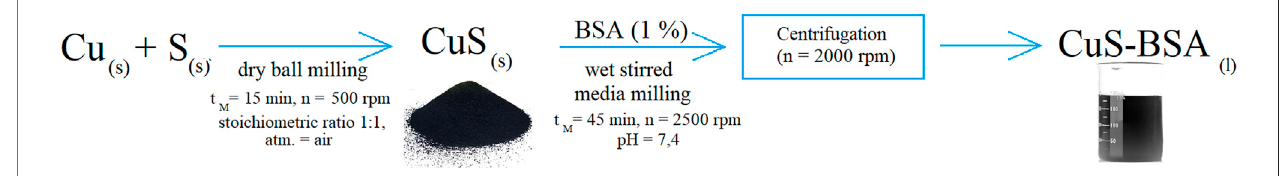
FIGURE 1 | The CuS-BSA nanosuspension preparation